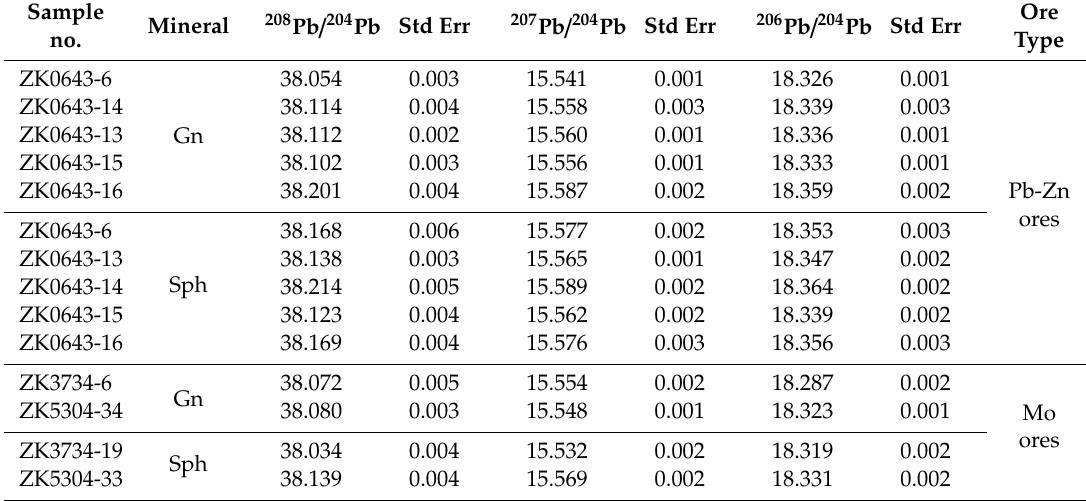
Figure 8. Sulfide Pb composition of both porphyry Mo and adjacent vein-type Pb-Zn deposits in the Diyanqinamu mine. Trends for the Upper Crust (C), Orogenic Belt (B), Mantle (A) and Lower Crust (D) are from Zartman and Doe [56]. Lead isotopic data of the molybdenite separates in Mo ores from Mineral abbreviations are same to those in Table Leng et al. [24]. Mineral abbreviations are the same as those in Figure 5. ( a ) Two-stage Pb isotope evolution diagram for sulfides from the Mo and Pb-Zn deposits in the Diyanqinamu mine. ( b ) 206 Pb/ 204 Pb versus 207 Pb/ 204 Pb diagram.